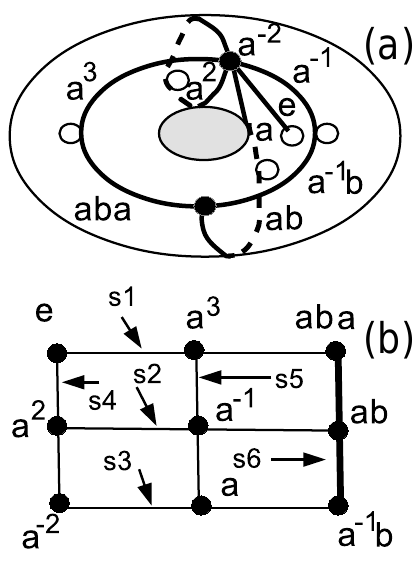
Figure 2. The map ( a ) leading to Mermin’s square ( b ). The two-point stabilizer subgroups of the permutation representation P corresponding to the dessin (one for each line) are as follows; s 1 = ( 2,3 )( 4,7 )( 5,6 ) , s 2 = ( 1,7 )( 2,8 )( 6,9 ) , s 3 = ( 1,4 )( 3,8 )( 5,9 ) , s 4 = ( 2,6 )( 3,5 )( 8,9 ) , and s 5 = ( 1,9 )( 4,5 )( 6,7 ) , s 6 = ( 1,8 )( 2,7 )( 3,4 ) , where the points of the square (resp. the edges of the dessin d’enfant) are labeled as [ 1,..,9 ] = [ e , a , a − 1 , a 2 , ab , a − 1 b , a − 2 , a 3 , aba ]